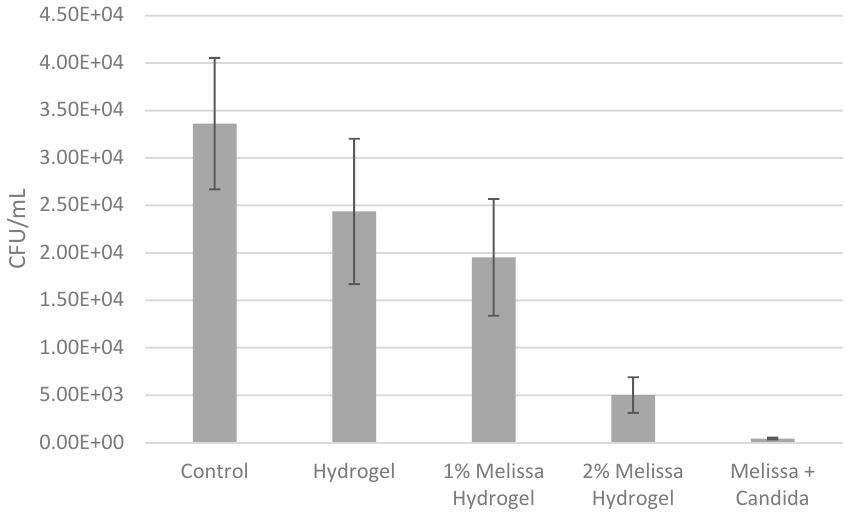
Figure 4. Retention assay after 1 h of exposure of C. albicans to 10% ( w / v ) methylcellulose hydrogels with or without 1 or 2% ( v / v ) Melissa officinalis.